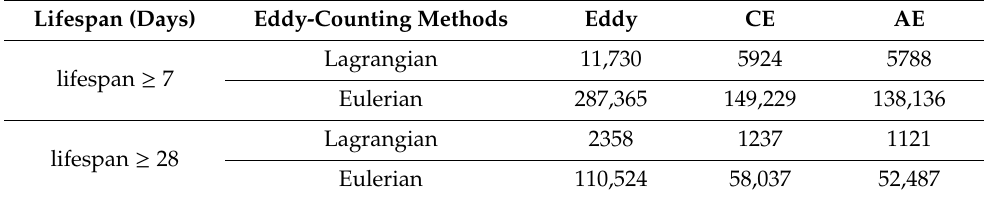
Table 1. Eddy number table counted by di ff erent methods.